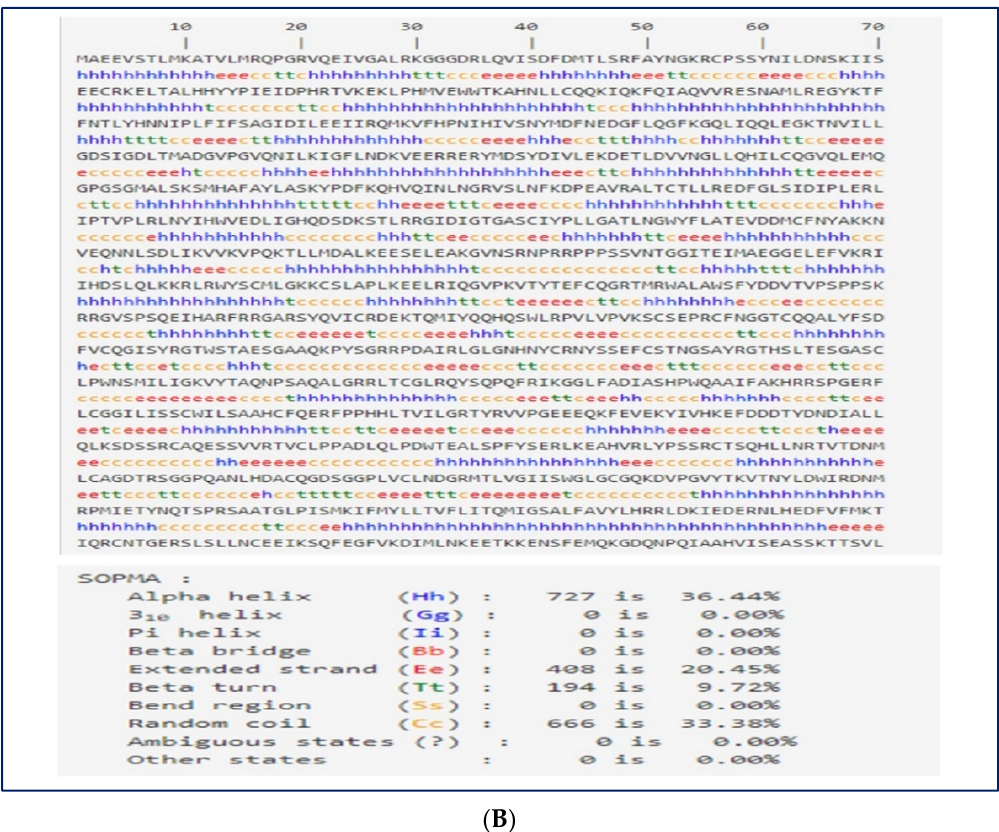
Figure 5. ( A ) Vaccine construct’s secondary structure. ( B ) Designed vaccine’s secondary structural analysis, revealing the fluctuations of its structural atoms, within a minimal range, depicting the stability of its structure.